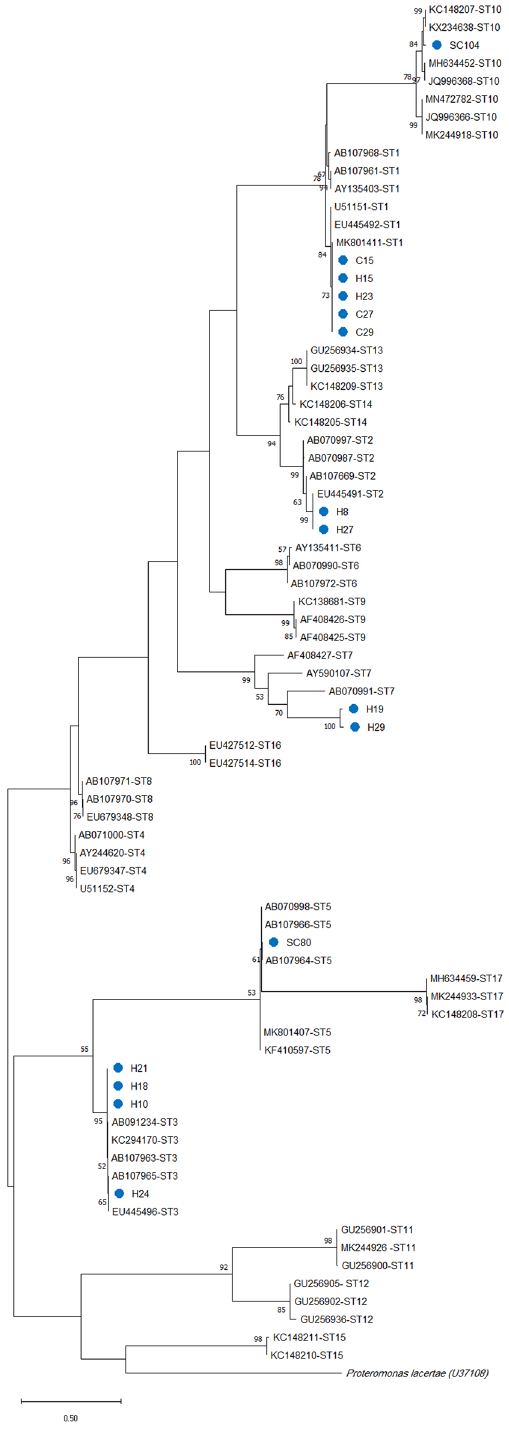
Figure 3. The phylogram of Blastocystis subtypes was inferred based on the nucleotide sequences of SSU rRNA gene. The evolutionary relationship of Blastocystis subtypes was constructed by the Maximum Likelihood method and Kimura 2-parameter model, based on the nucleotide sequences of SSU rRNA gene of Blastocystis isolated from stray cats [SC], household cats [C], and cat owners [H] in this study (blue circles) compared with nucleotide sequences of Blastocystis subtypes retrieved from GenBank, with Proteromonas lacertae (U37108) as outgroup. Bootstrap values obtained from 1000 replicates are indicated on branches in percentage; only bootstrap values > 50% are displayed. Evolutionary analyses were conducted in MEGA